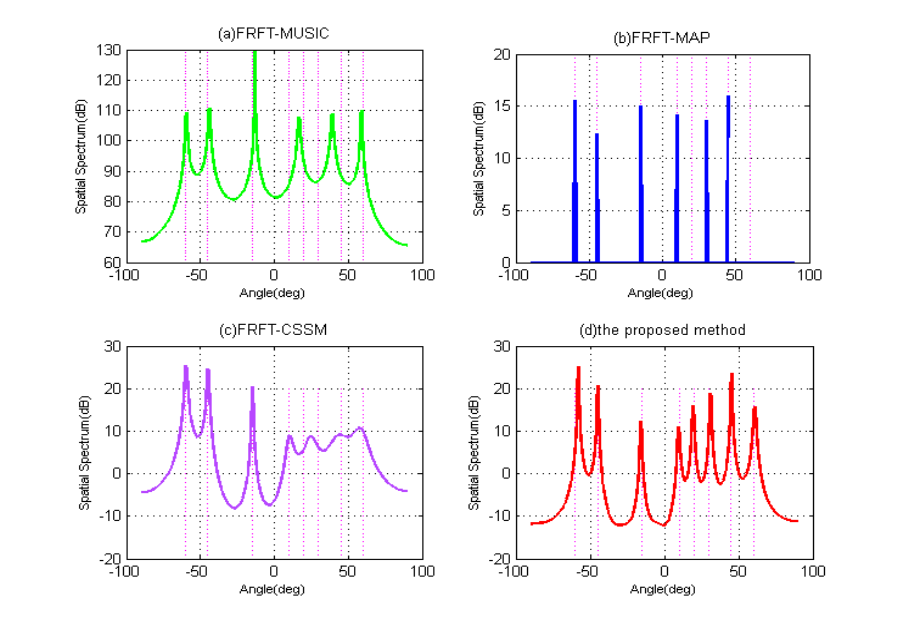
Figure 7. DOFs performance comparison with respect to spatial spectrum when 8 wideband LFM signals impose on the array. ( a ) FRFT-MUSIC; ( b ) FRFT-MAP; ( c ) FRFT-CSSM; ( d ) The proposed